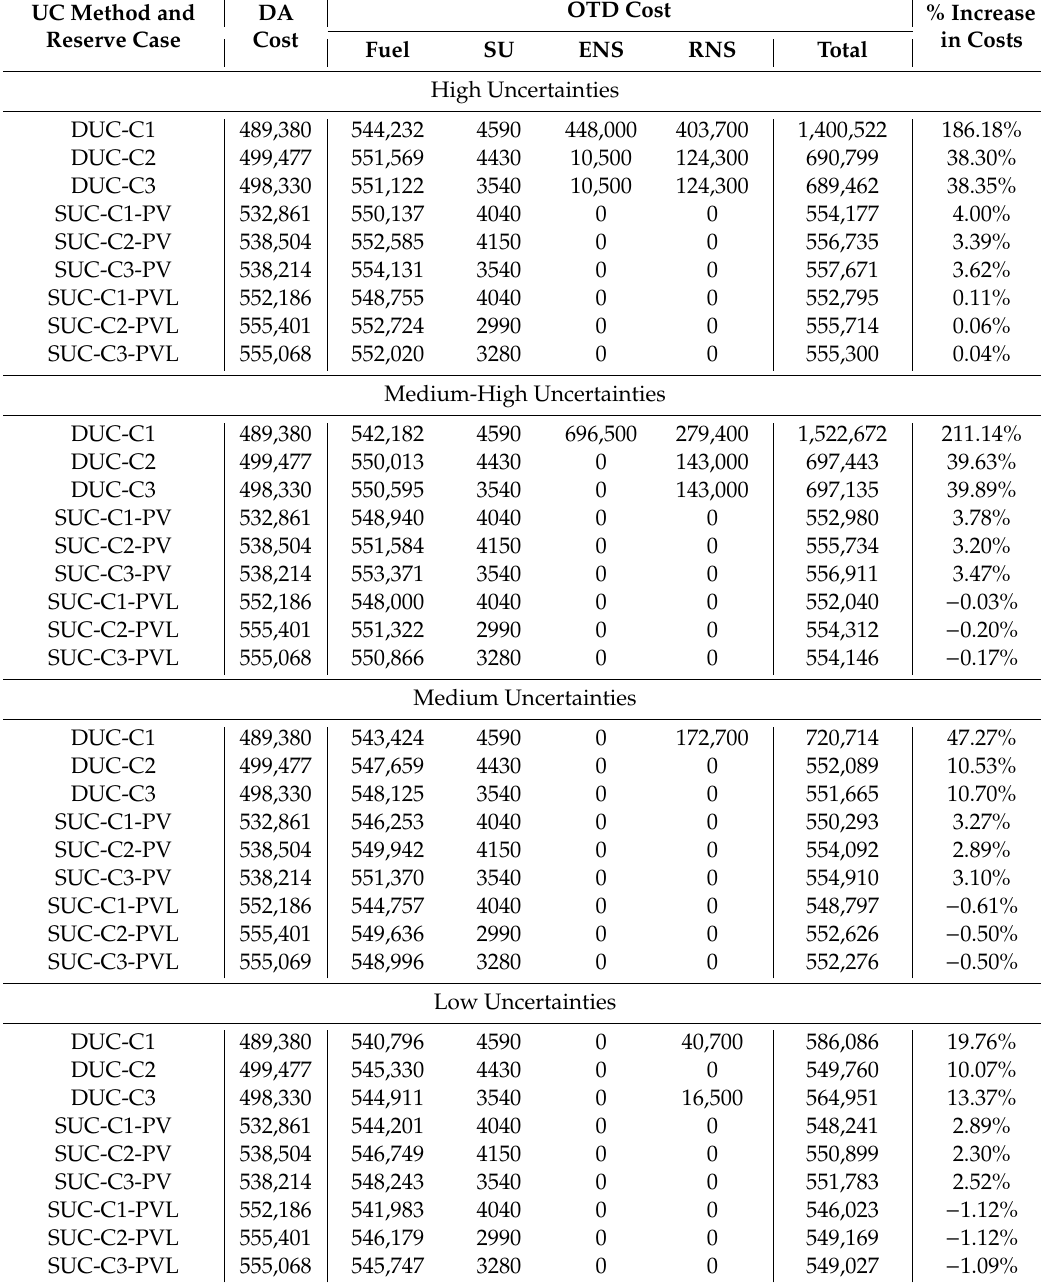
Table 3. Day-ahead and on-the-day